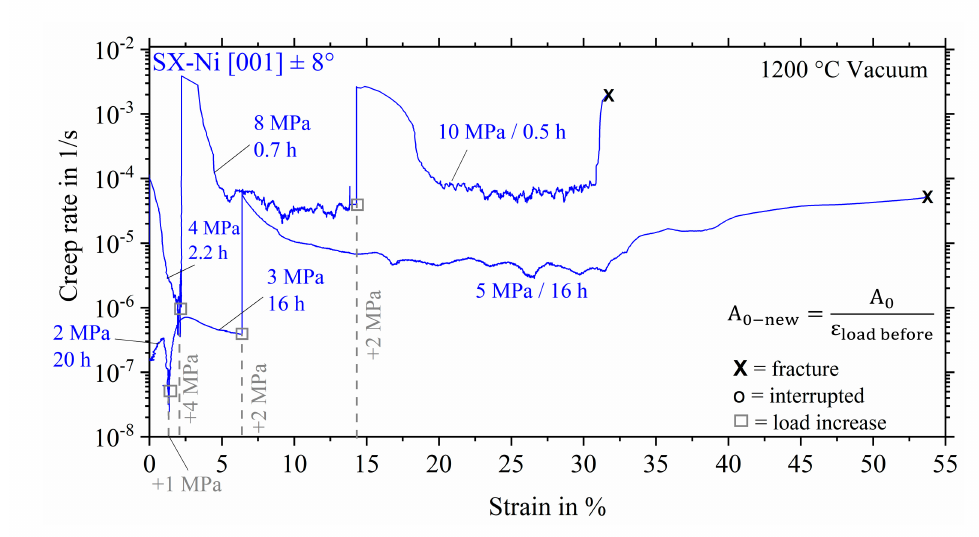
Figure 6. Creep rate over strain diagram for the creep tests of the single crystalline pure nickel at 1200 ◦ C with di ff erent stress levels by using stress increase under